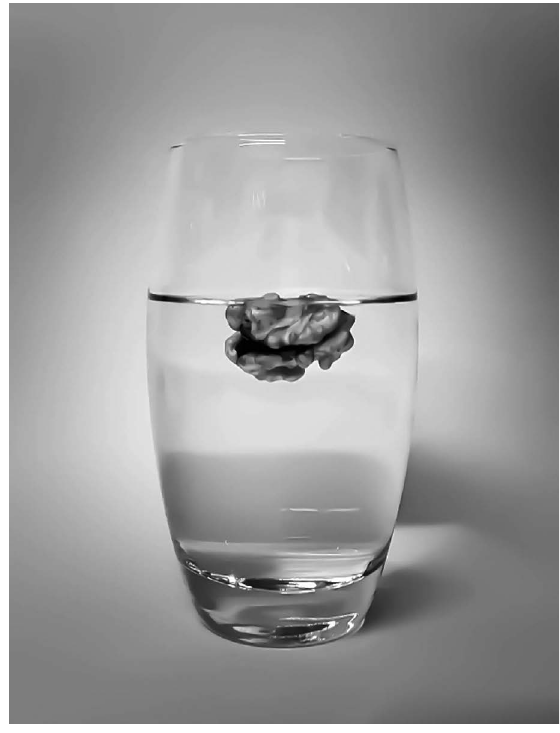
Figure 7. Manuel A. García (2017) Ahogada [Drowned]. Photograph taken by a student that reflects on the abusive application of traditional teaching methodologies, such as rote learning, and the drowning of creativity caused by these methodologies. © M.A. García. Primary Education student. Bachelor’s degree student in Primary